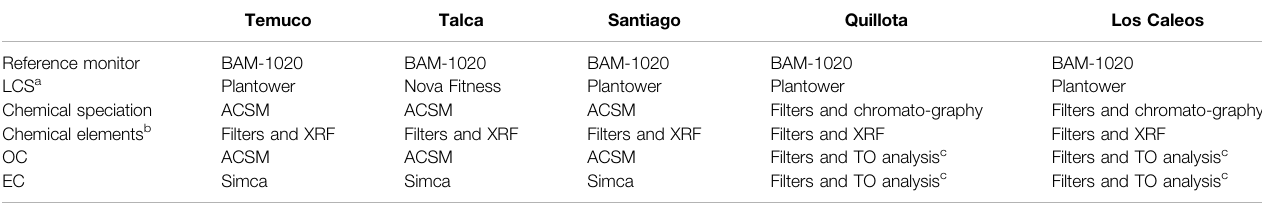
TABLE 1 | Instruments and analytical techniques used at each